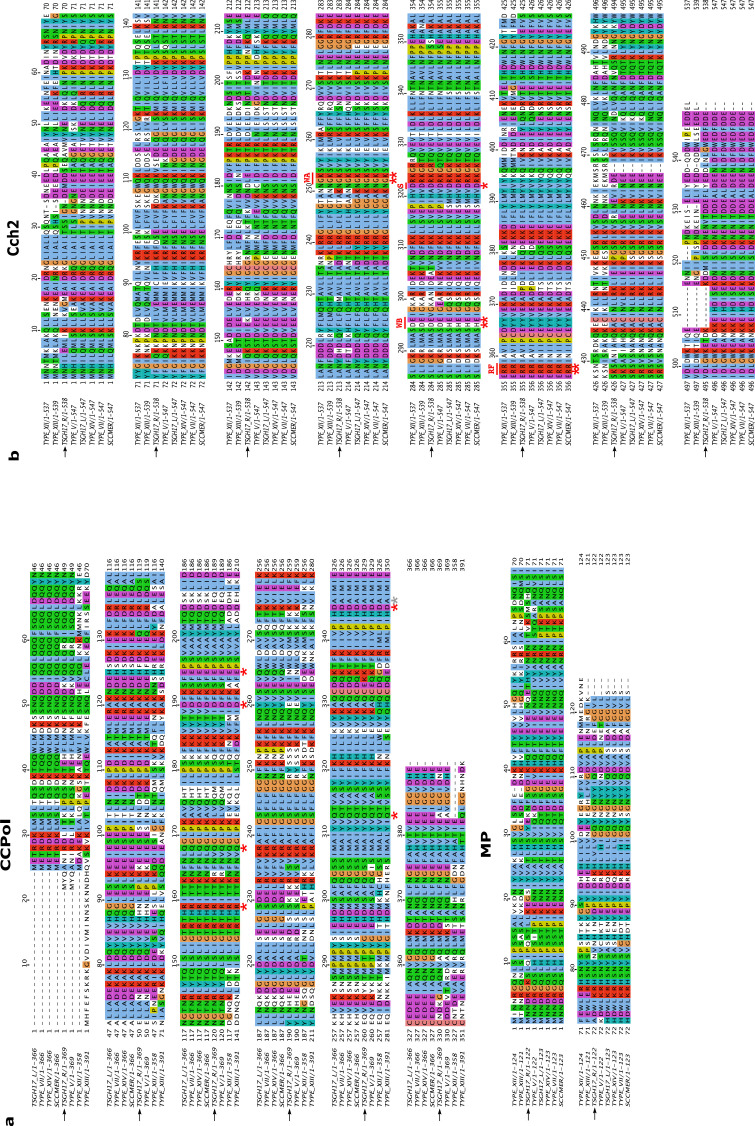
Sequence alignments of Cch2 operon proteins CCPol, MP, and Cch2.The alignments were prepared in Clustal Omega (Sievers et al., 2011) and visualized in Jalview (with Jalview coloring) (Waterhouse et al., 2009). The following SCC sequences were used for the alignments: the two gene clusters (SCCmer-like L and type V-like R) from a composite SCCmec from TSGH17 strain (SCC accession number AB512767), type V element from WIS strain (AB121219), type VII from JCSC6082 (AB373032), type XII from strain BA01611 (JCSC6082), type XIII from isolate 55-99-44 (MG674089), type XIV from strain SC792 (LC424989), and SSCmer (carrying a mercury resistance cluster) from strain 85/2082 (AB037671). The proteins investigated in this study are marked with arrows. Residues predicted to be important for activity for CCPol (based on similarities to other A-family polymerases Kiefer et al., 1997) and Cch2 (based on similarities to Cch and the SaPI5 Rep protein Mir-Sanchis et al., 2016) are marked with red asterisks (with a grey asterisk marking an alanine residue which in other A-family polymerases is invariably a catalytic glutamic acid). For Cch2 alignment, predicted motifs are: WA – Walker A motif, WB – Walker B motif, S – sensor I, and RF – Arginine finger.